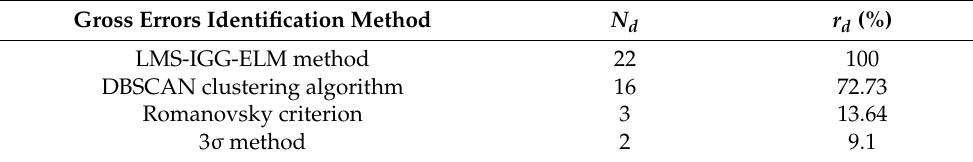
Table 5. Comparison table of gross errors identification rate of measuring point